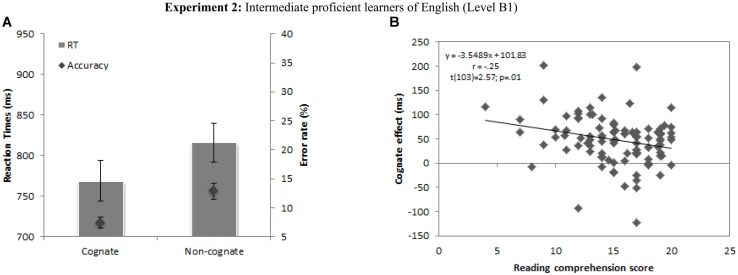
 (A) Mean latencies and error rates for cognate and non-cognate words in Experiment 2. Error bars represent 95% confidence intervals. (B) Correlation between individuals’ cognate effects and reading comprehension scores for B1 group of English learners.